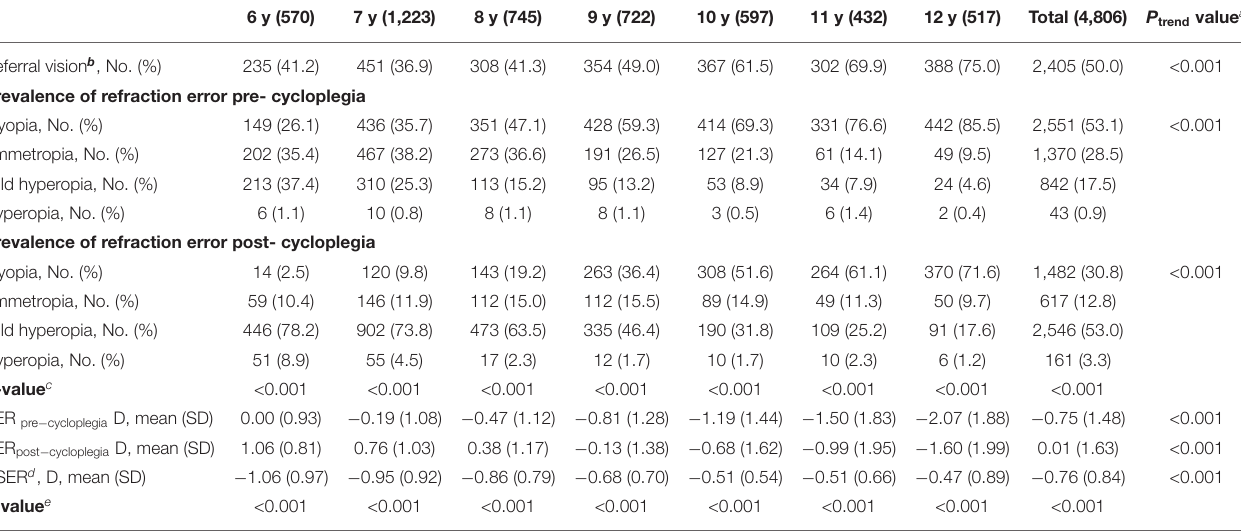
TABLE 1 | The prevalence of referral vision and refraction errors, and spherical equivalence refraction before and after cycloplegia among 6- to 12-year-old children in Beijing, No.